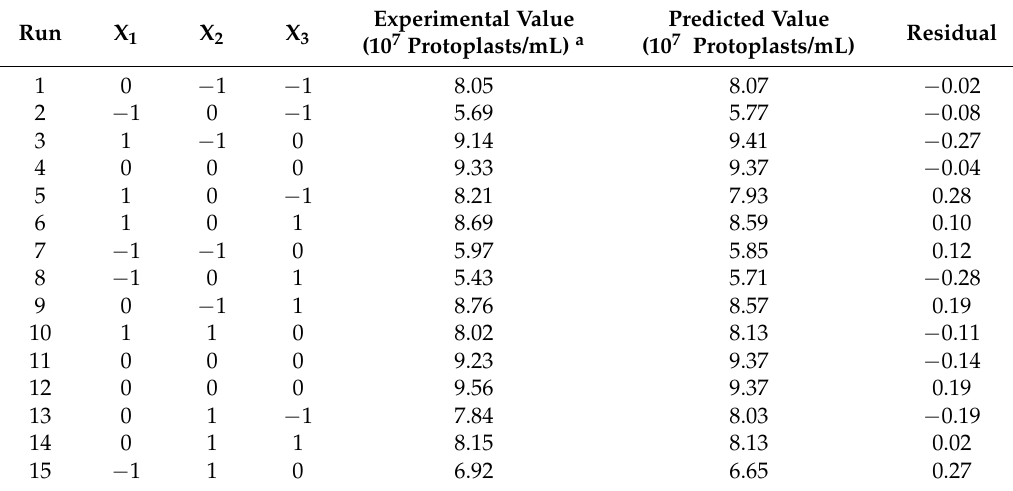
Table 2. Experimental design using Box–Behnken design, experimental value, and predicted value.